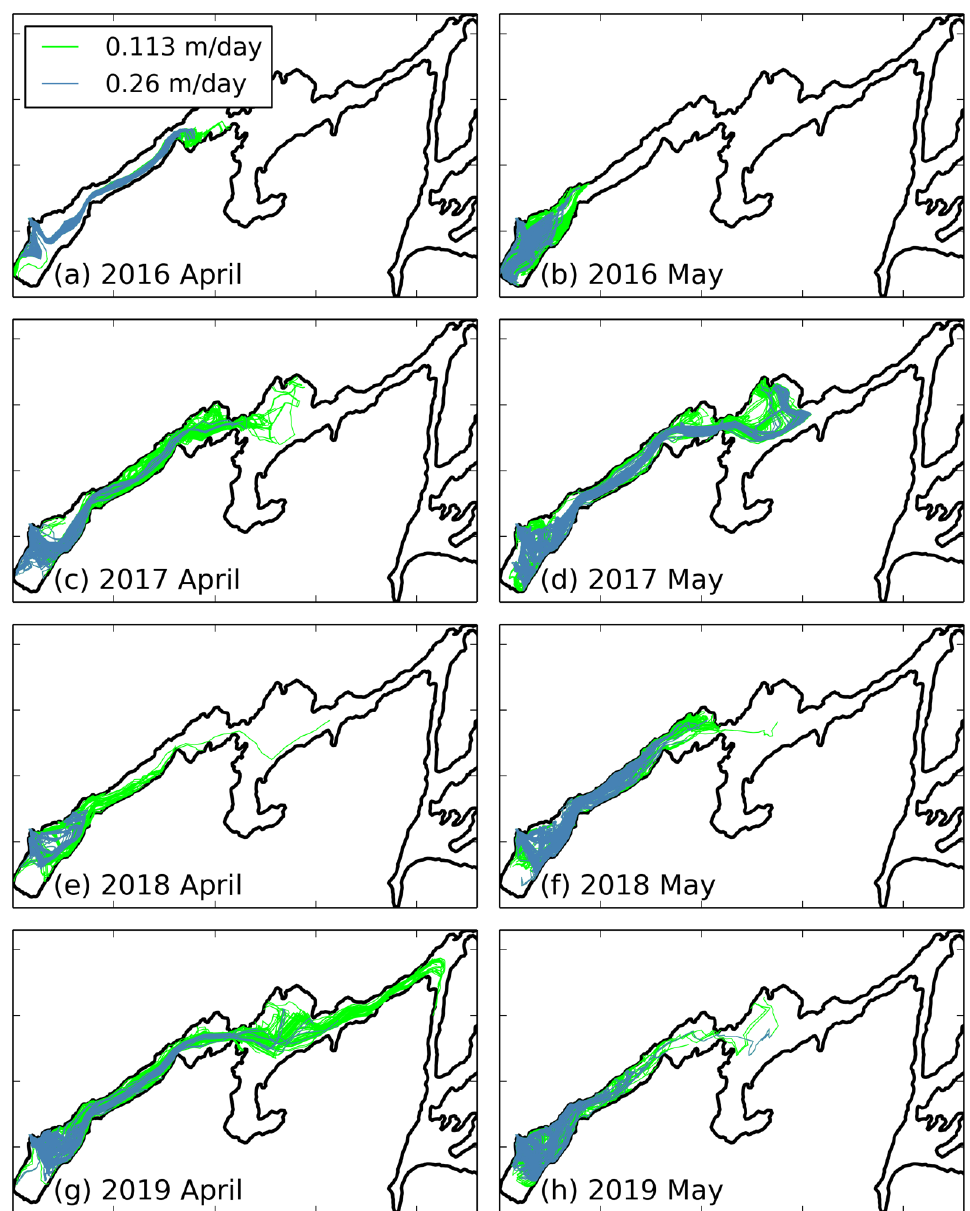
Figure 9. Trent River particle paths for 2 settling speeds tracked for the months of ( a , c , e , g ) April and ( b , d , f , h ) May in the years 2016–2019.